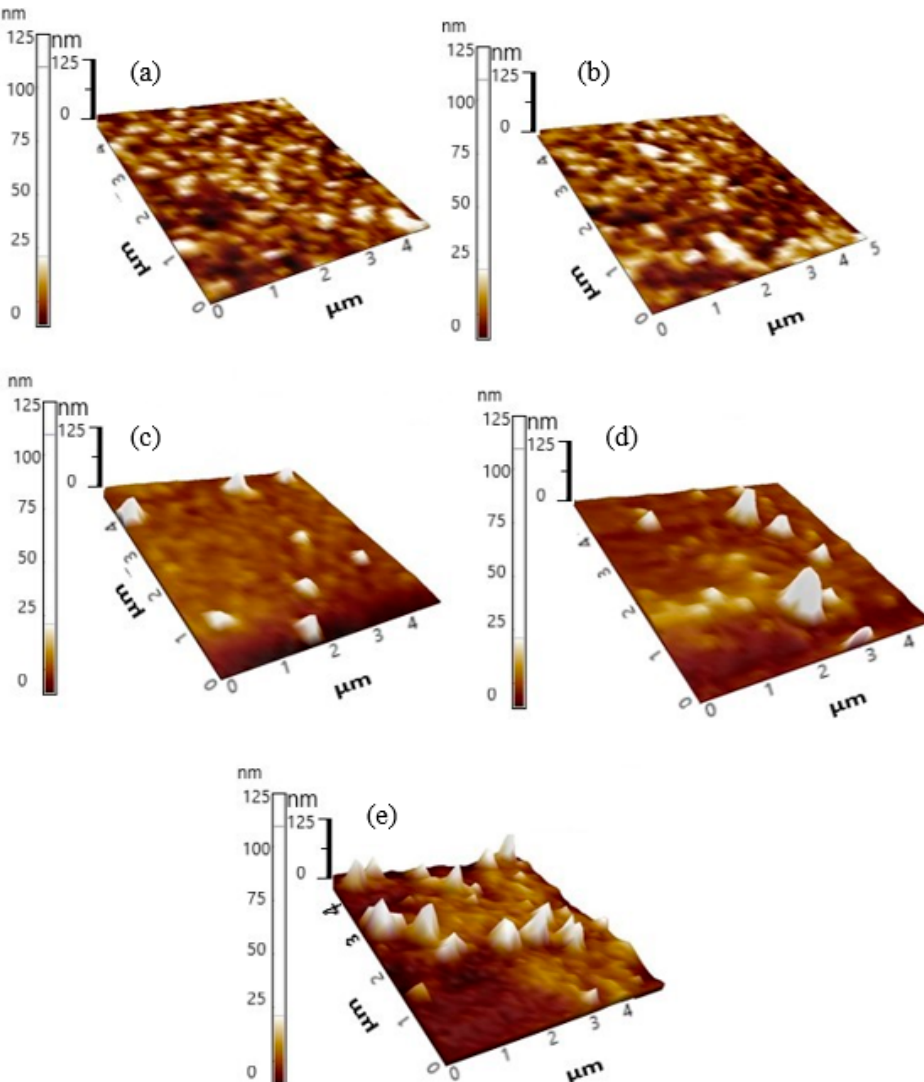
Figure 8. SPM images of binary, ternary and nanocomposite thin films ( a ) PFO / 0.5 wt.% MEH-PPV; ( b ) PFO / 0.3 wt.% F8BT / 0.5 wt.% MEH-PPV; ( c ) PFO / 0.3 wt.% F8BT / 0.5 wt.% with 10 wt.% TiO 2